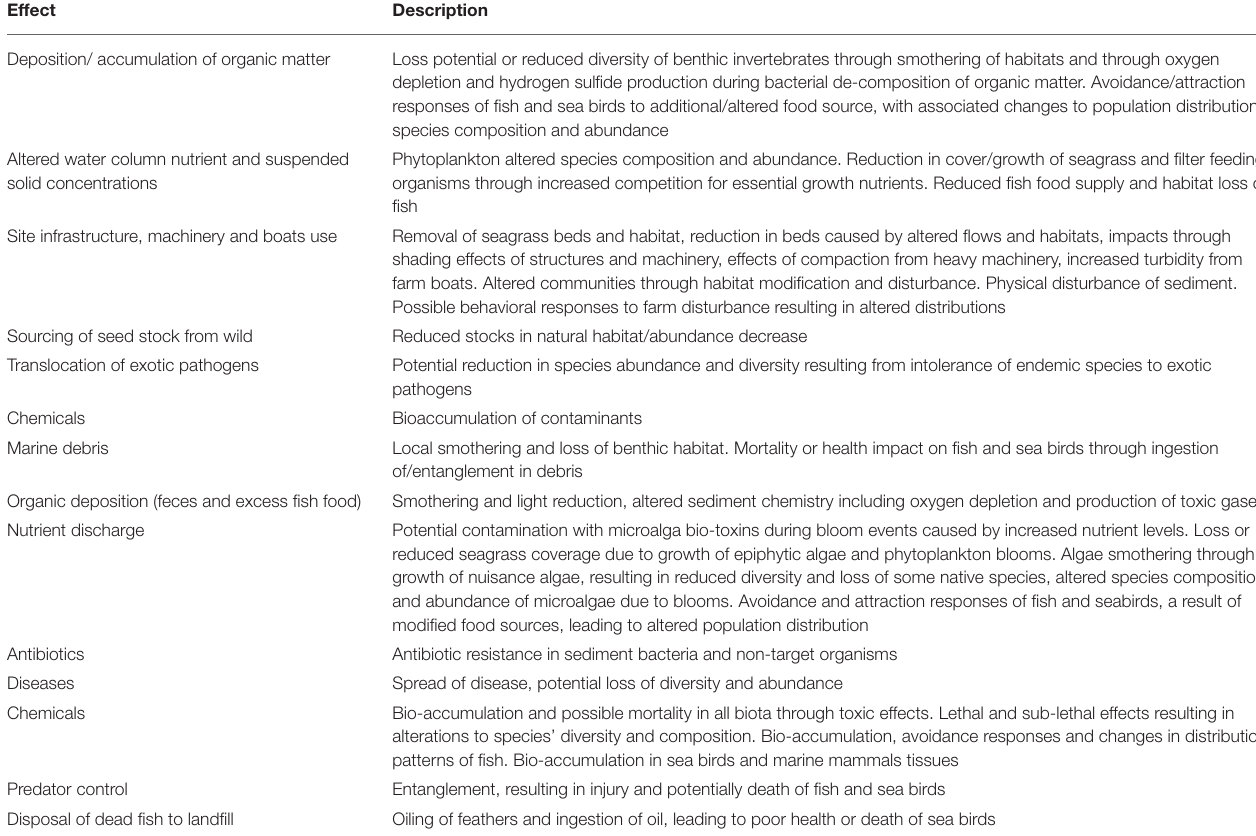
TABLE 2 | Description of selected environmental effects of